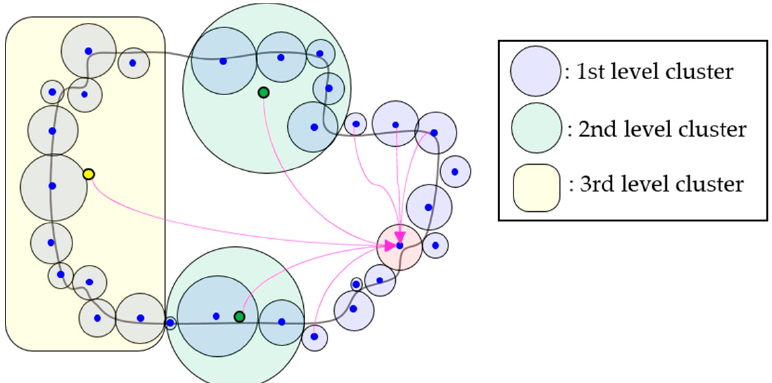
Figure 6. Hierarchical transfer function calculations in the MLFMA.